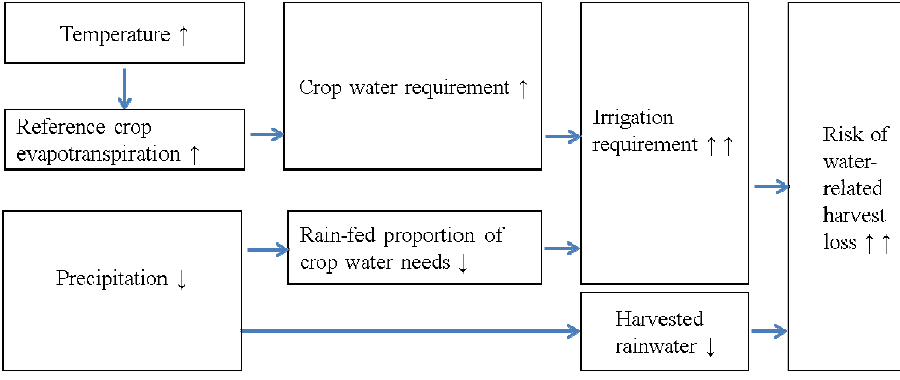
Figure 6. Impacts of worsening future climate conditions with higher temperatures and less precipitation on rainwater